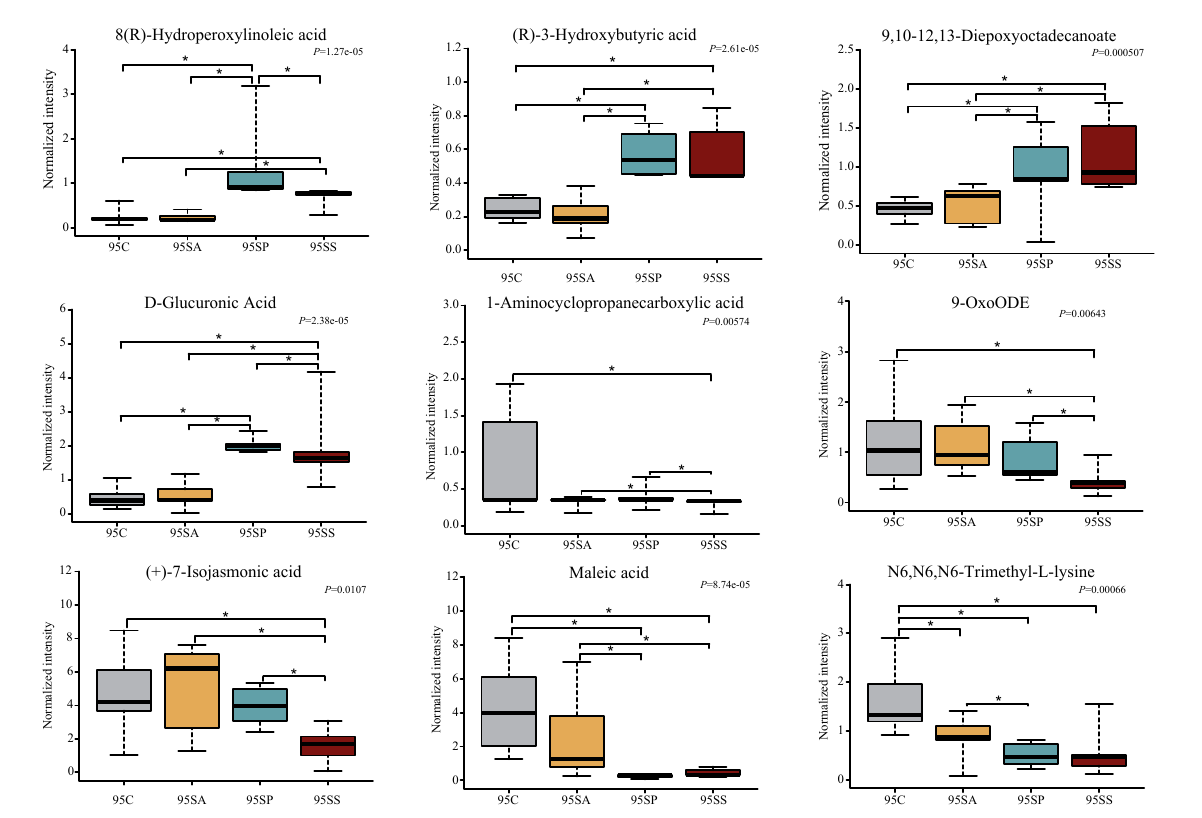
FIGURE8 The box plots of different metabolites at 95 days of age. Asterisk represents P < 0.05. 95C, sow fed with basal diet; 95SA, sow fed with antibiotic; 95SP, sow fed with probiotics; 95SS, sow fed with synbiotics.